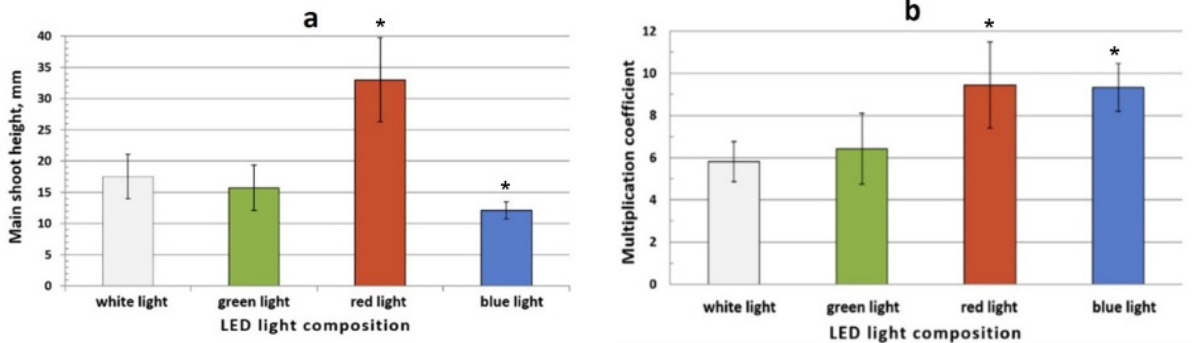
Figure 6. ( a ) Main shoot heights and ( b ) multiplication coefficients of S. rebaudiana microshoots in in vitro cultures under different spectra of monochrome LED lighting. Means ± standard errors at α = 0.05 according to the ANOVA test ( n = 60). *-variants that had significant differences between control treatments (white light).